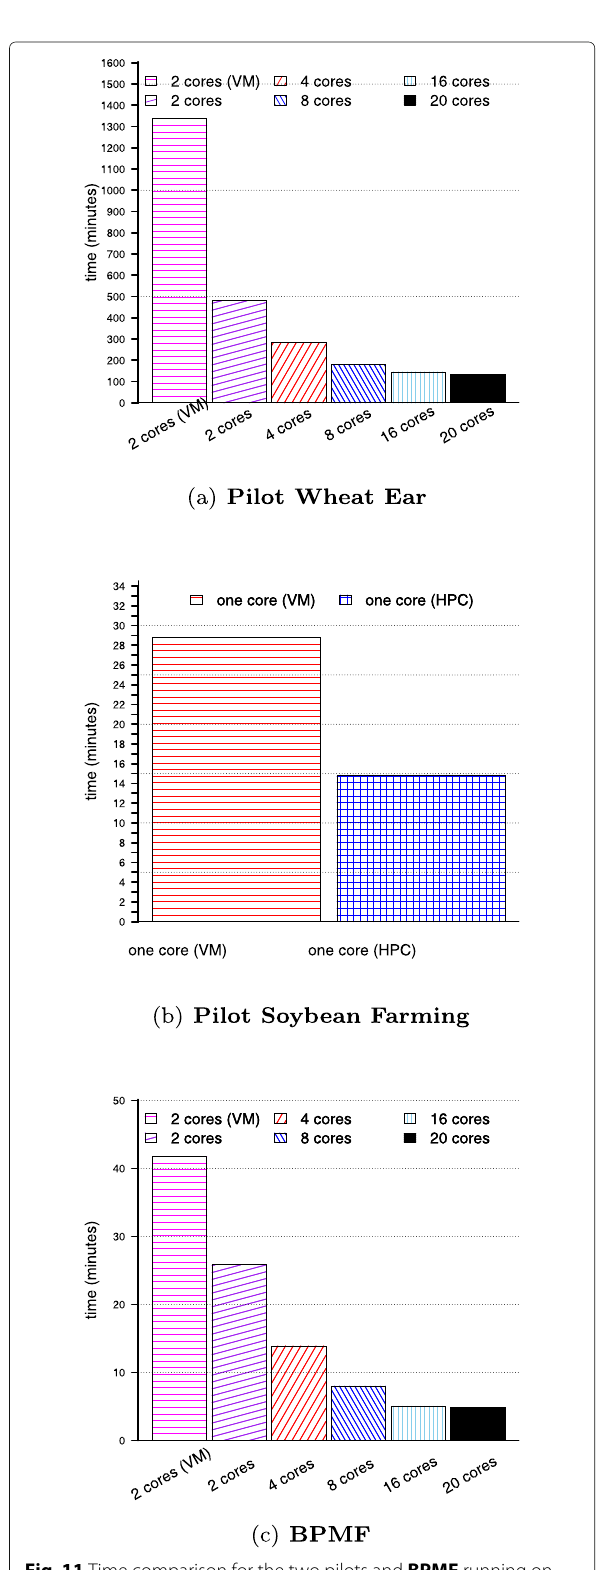
Fig. 11 Time comparison for the two pilots and BPMF running on the Cloud node and HPC node